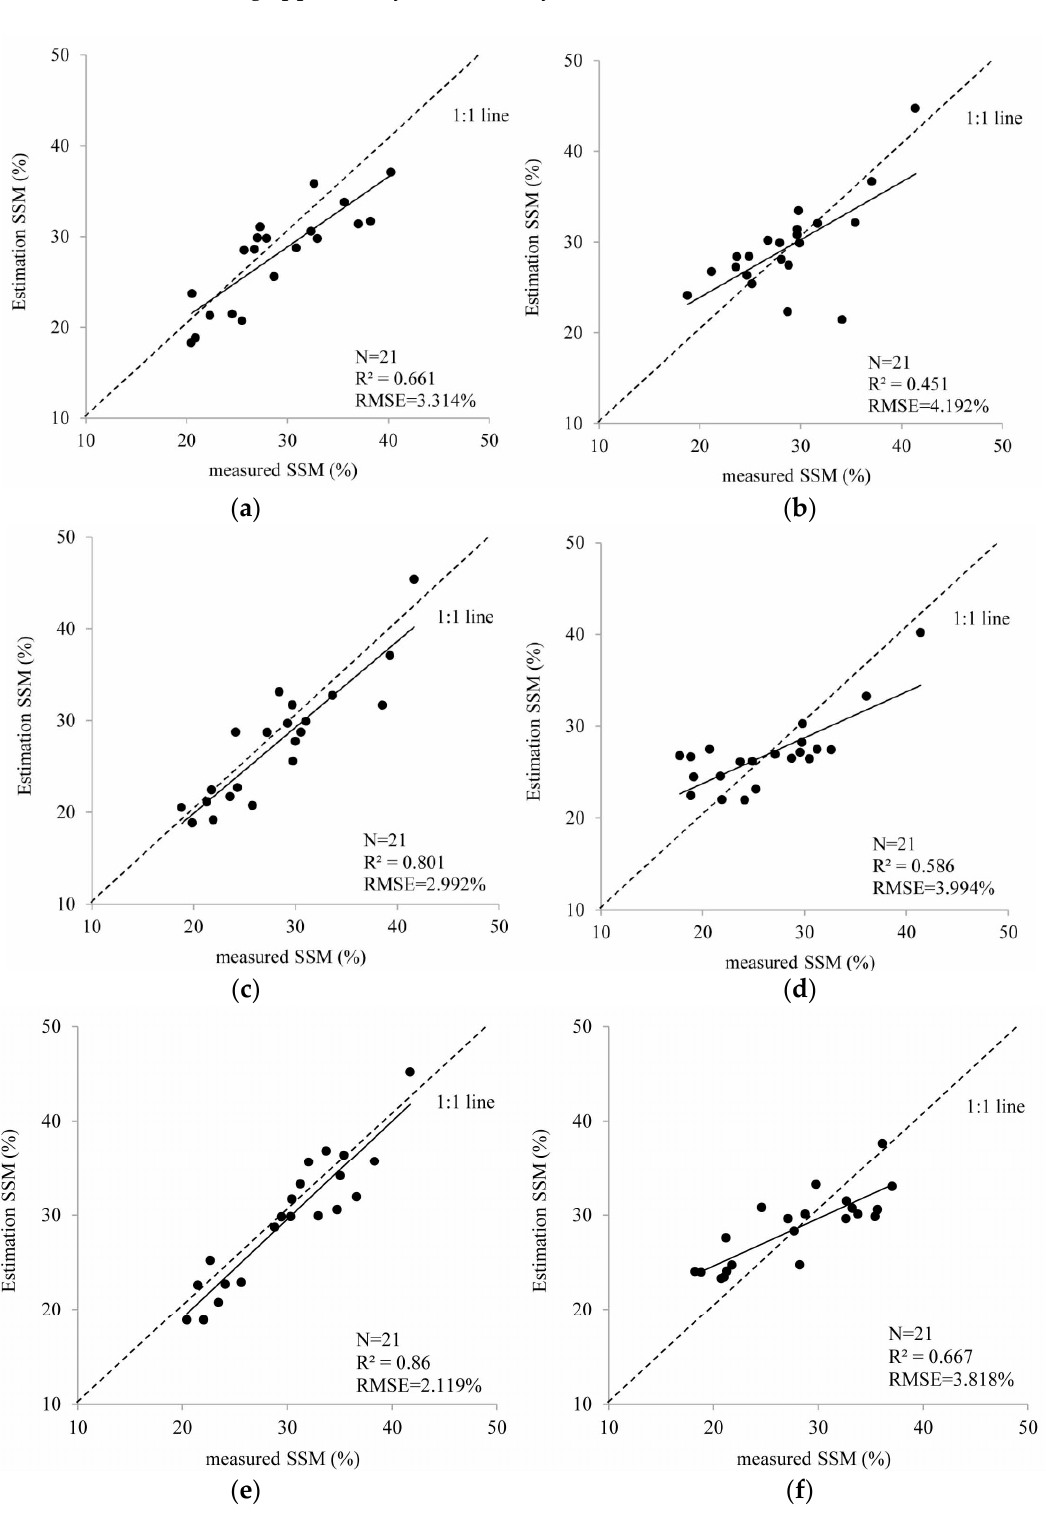
Figure 6. Scatterplot of estimated versus measured SMC (%) values. ( a ) Radar backscattering coefficient of VV polarization. ( b ) Radar backscattering coefficient of VH polarization. ( c ) Soil backscattering coefficient of VV polarization by the original WCM. ( d ) Soil backscattering coefficient of VH polarization by the original WCM. ( e ) Soil backscattering coefficient of VV polarization by the modified WCM. ( f ) Soil backscattering coefficient of VH polarization by the modified WCM.